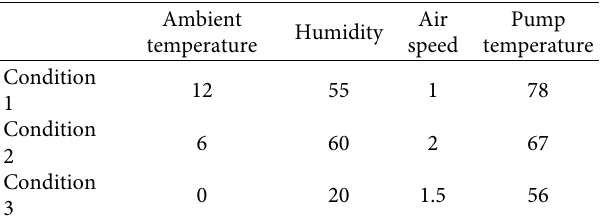
Table 2: Working conditions of heat pump under different working